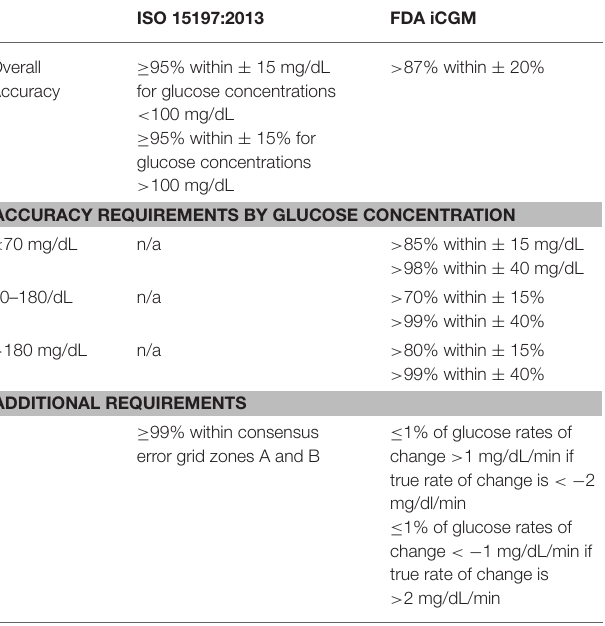
TABLE 7 | Comparisons of the accuracy requirements for blood glucose meters, as dictated by the ISO 15197:2013, and iCGM, as required by the US FDA. ISO